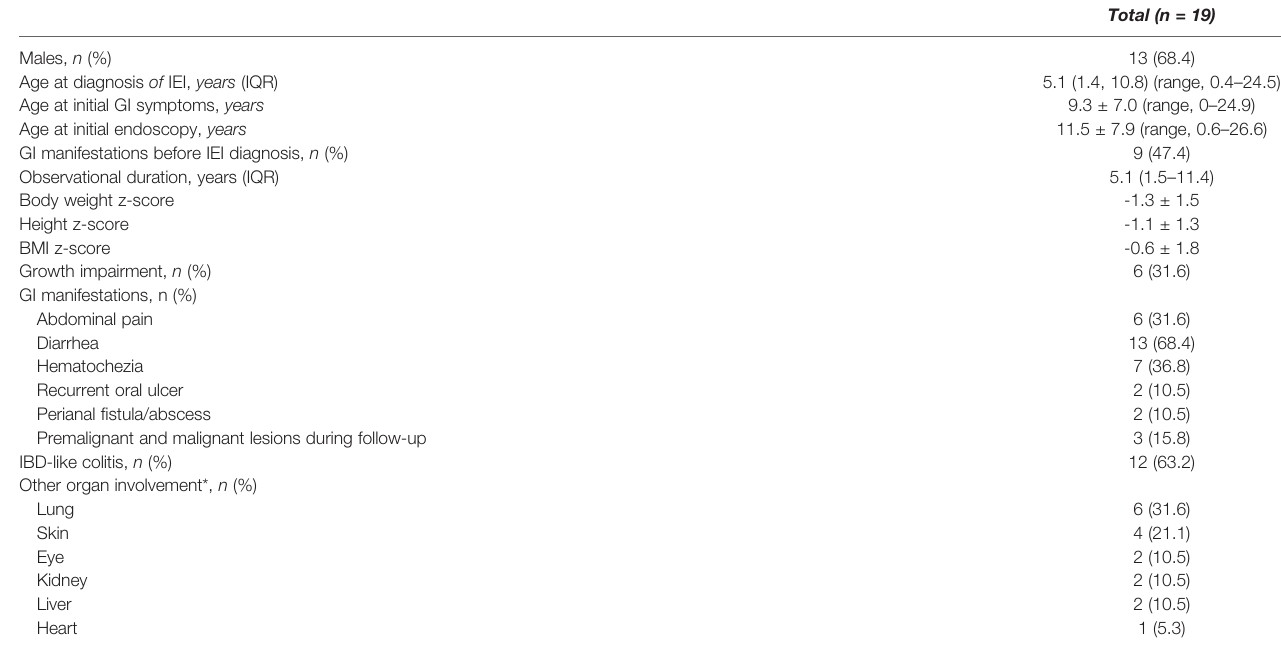
TABLE 2 | Baseline characteristics of IEI patients with GI manifestations required endoscopic evaluation.